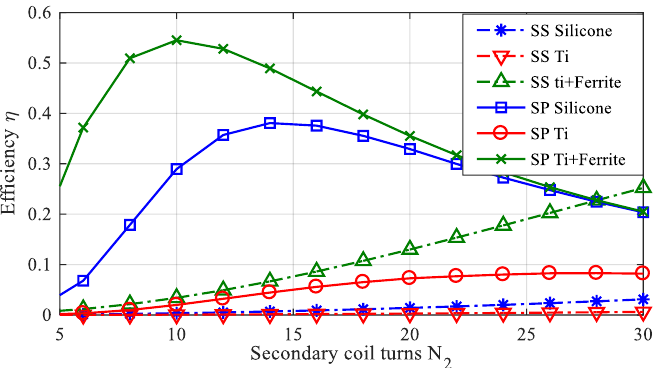
Figure 12. E ffi ciency η vs. N 2 for SS and SP compensation Figure 12. Efficiency η vs. N 2 for SS and SP compensation topologies.